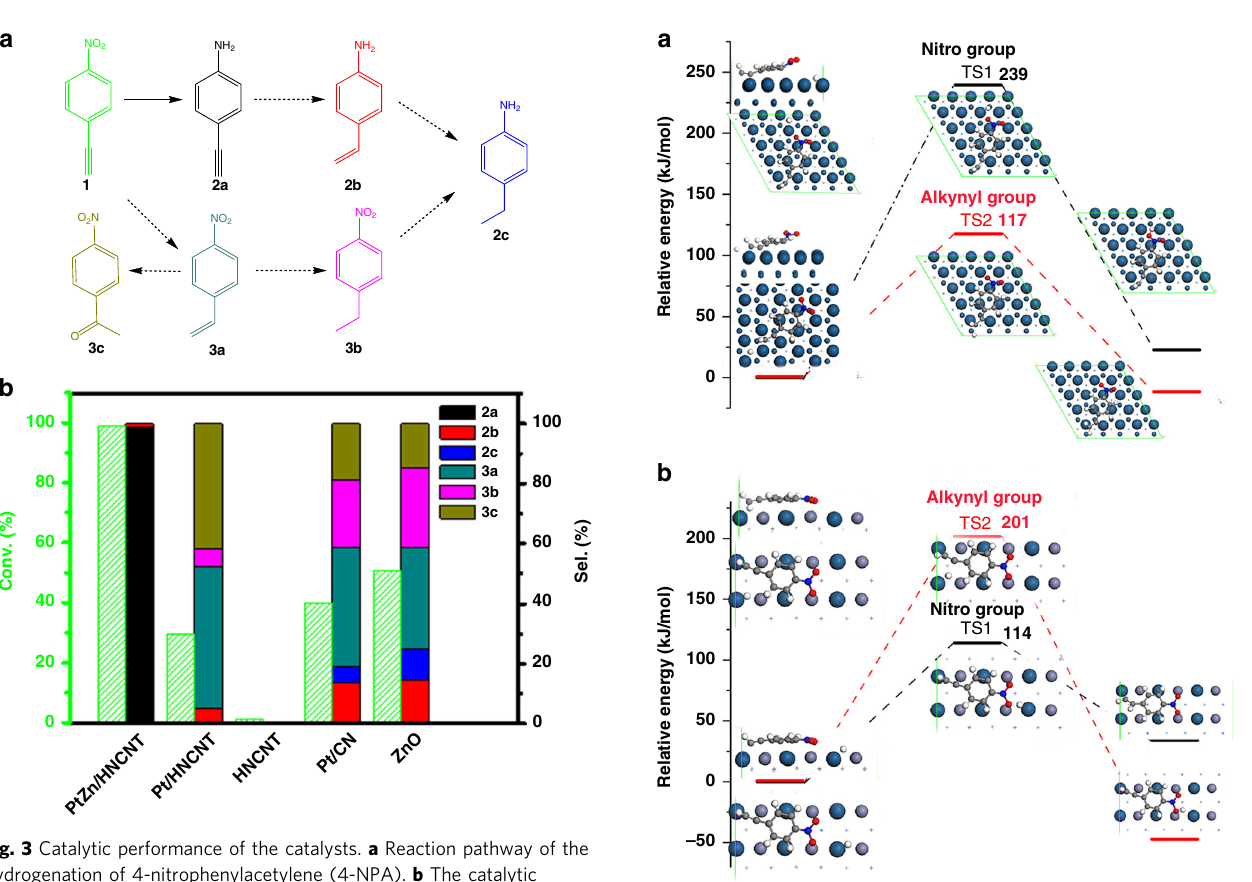
Fig. 4 DFT calculations of 4-nitrophenylacetylene over the catalysts. a , b The fi rst elementary hydrogenation reaction steps on both nitro and alkynyl groups over Pt(111) ( a ) and PtZn(022 ̄ ) ( b ) surface. Numbers labeled indicate the barriers of elementary steps (unit: kJ mol − 1 Fig. 49). The diffusion barrier is 29 kJ mol − 1 . Meanwhile, the hydrogenation on alkynyl group is along 〈 100 〉 direction.